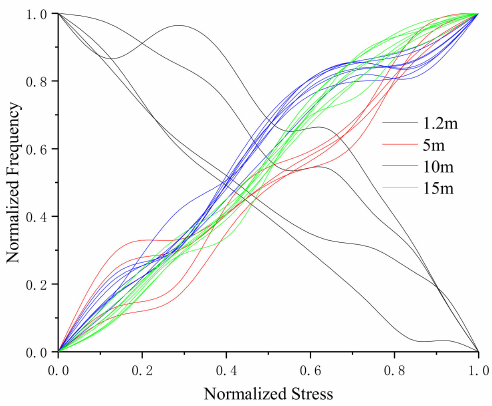
Figure 12. Stress-frequency curve of four steel